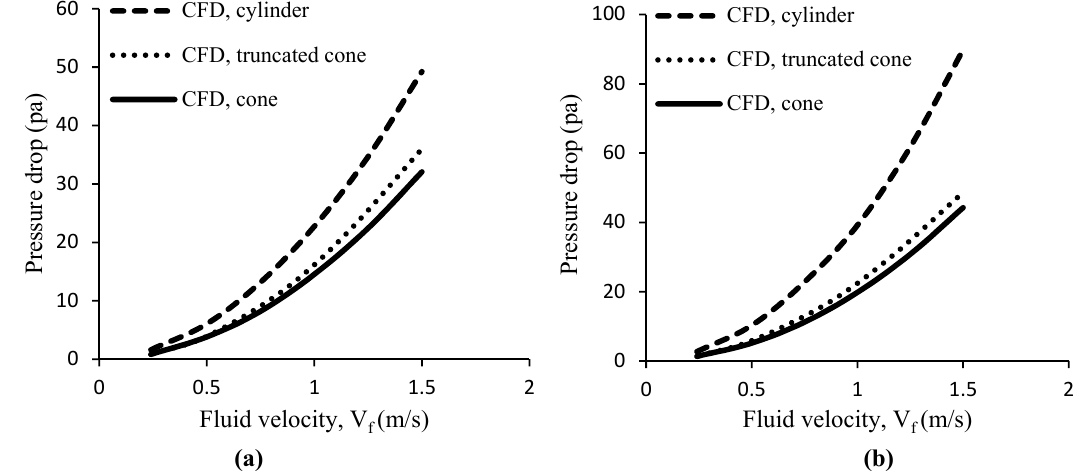
Fig. 12. Pressure drop variations vs. fluid velocity for cylindrical, truncated cone and cone particles in a turbulent flow regime: a) V 8.34×10 5 mm 3 and b) V = 94.9×10 5 mm 3 b